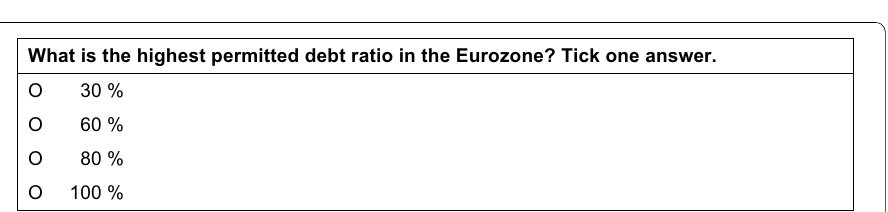
Fig. 1 Example of a text-based introduction to the Euro crisis issue